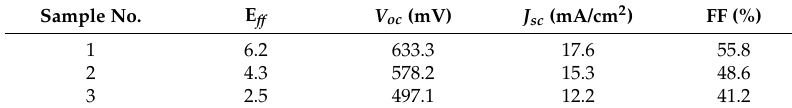
Table 2. Performance of CZTS solar cells.